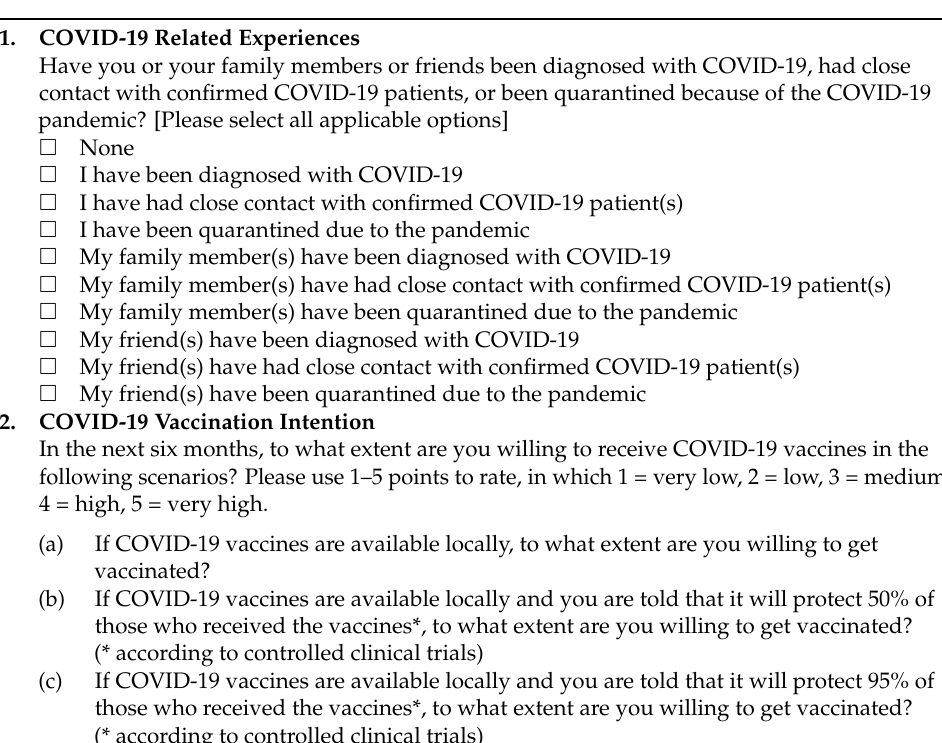
Table A1. The COVID-19 Vaccination Intentions